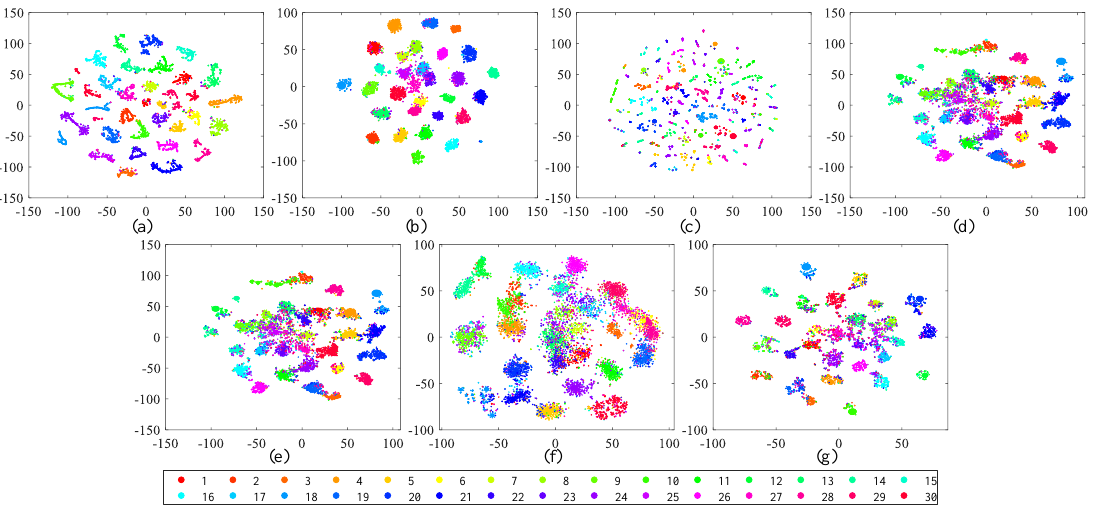
Figure 15. Two-dimensional scatterplots of different hash codes (128 bits) obtained by t-SNE over AID with 30 semantic scenes. The relationships between number ID and scenes can be found in Table 2: ( a ) SDAH (Our method); ( b ) SSDH; ( c ) BTNSPLH; ( d ) KSH; ( e ) DQH; ( f ) DHN; and ( g )